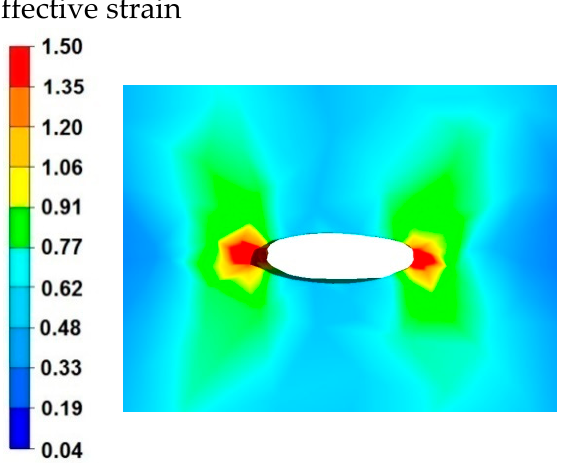
Figure 7. Distribution of effective strain values within the modelled discontinuity at a 20% reduction.